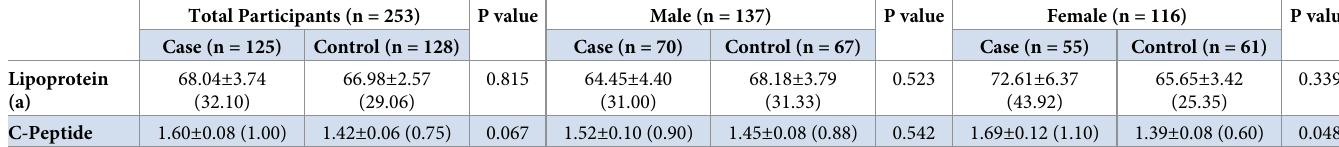
Table 1. Mean ± SE and Interquartile range � of serum lipoprotein (a) and C-Peptide‡ levels of participants according to gender. Total Participants (n = 253) P value Male (n = 137) P value Female (n = 116) P value Case (n = 125) Control (n = 128) Case (n = 70) Control (n = 67) Case (n = 55) Control (n = 61) Lipoprotein 68.04 ± 3.74 (a) (32.10)